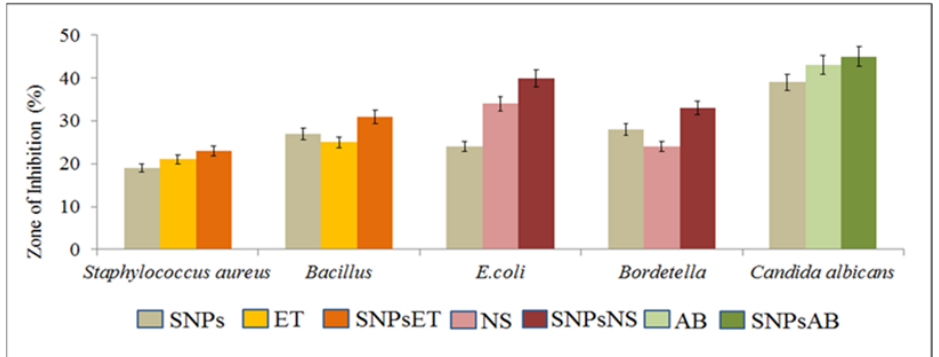
Figure 5. Antimicrobial and antifungal activity of SNPs of Citrus limon extract against di ff erent strains. Note: SNPs (sulfur nanoparticles), ET (erythromycin thiocyanate), SNPsET (sulfur nano- particles embedded with erythromycin thiocyanate), NS (neomycin sulfate), SNPsNS (sulfur na- noparticles embedded with neomycin sulfate), AB (Amphotericin B), SNPsAB (sulfur nanoparticles embedded with Amphotericin B).